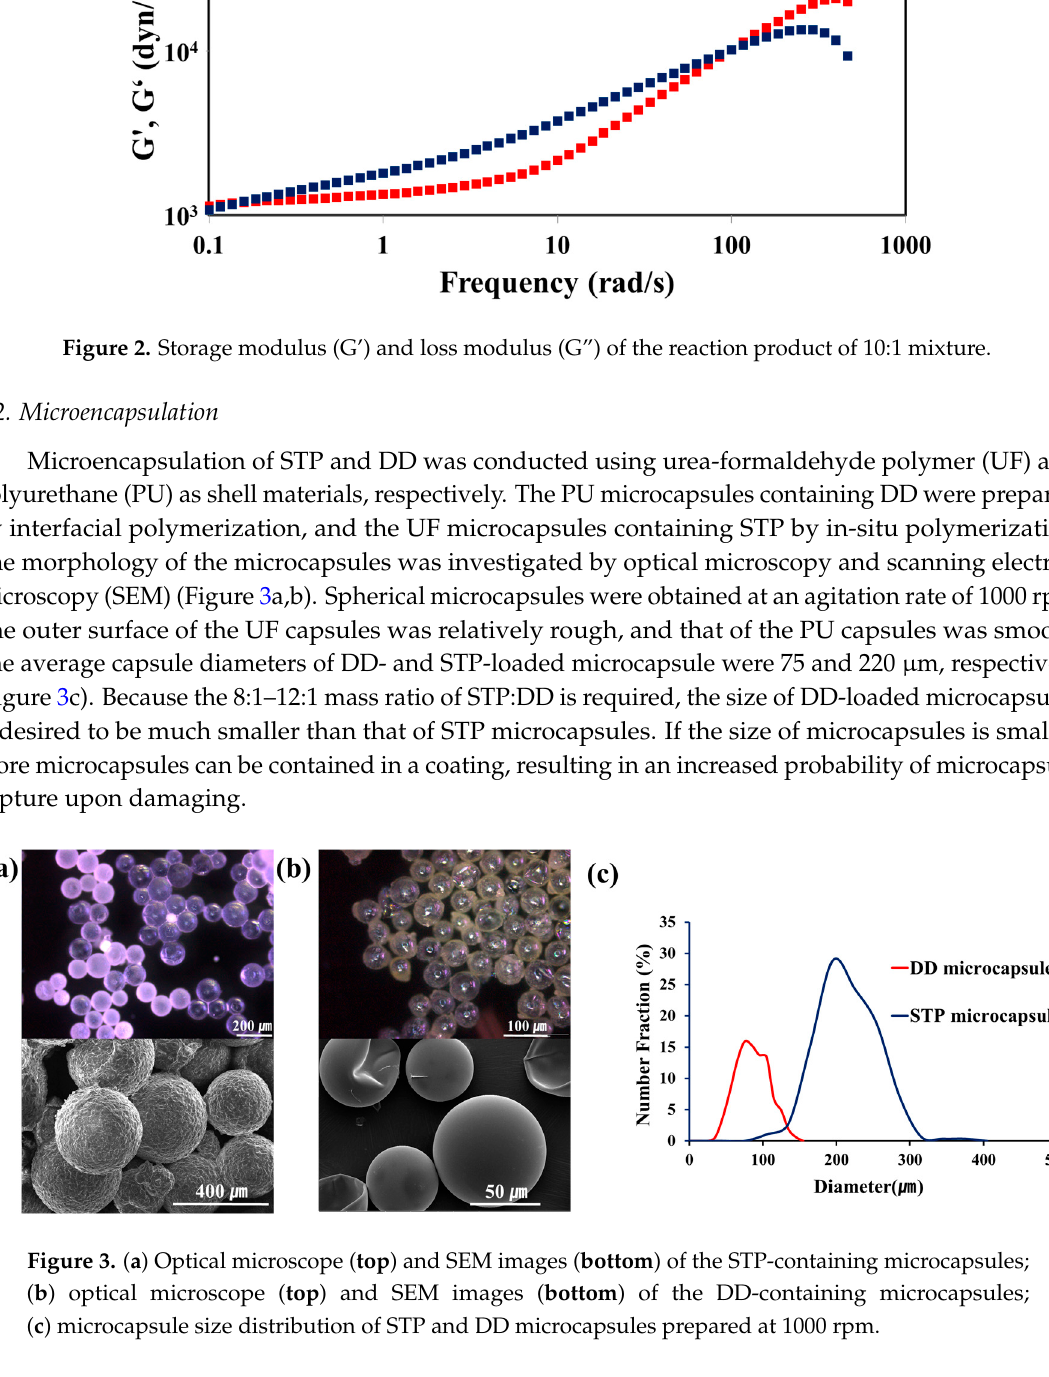
Figure 2. Storage modulus (G’) and loss modulus (G”) of the reaction product of 10:1 mixture.